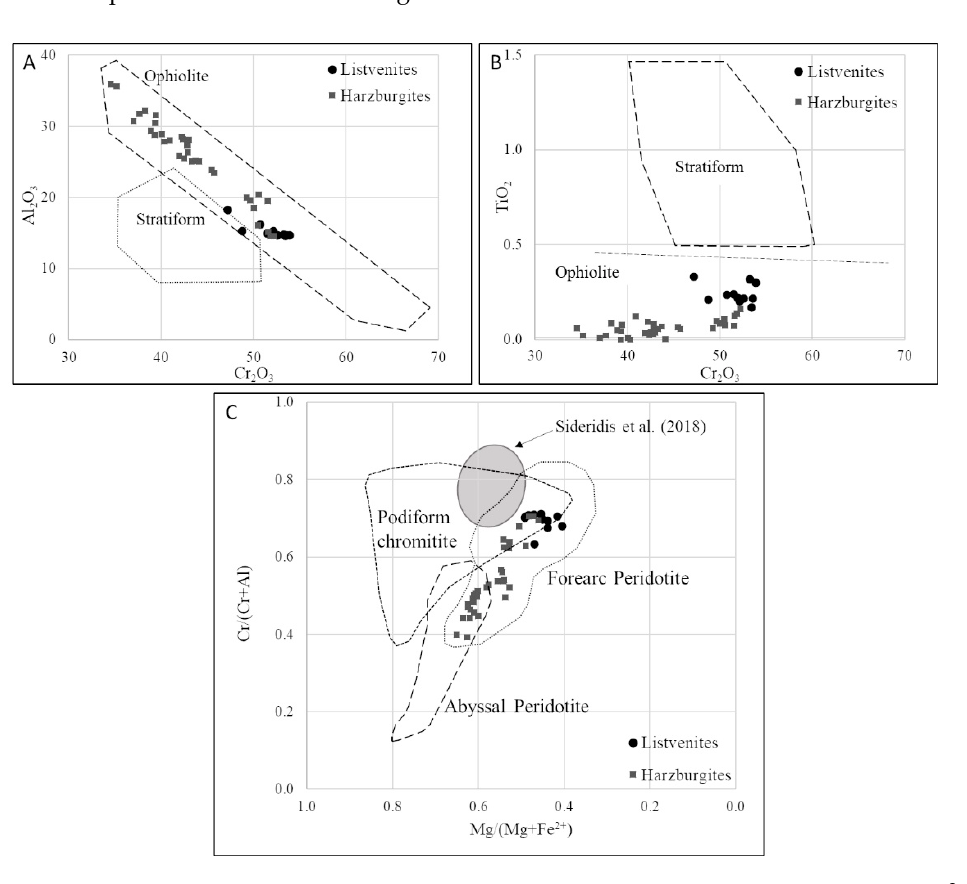
Figure 9. Cr 2 O 3 vs. Al 2 O 3 ( A ) and TiO 2 ( B ) of the Rachoni peridotite chromites; ( C ) Mg/(Mg+Fe 2+ ) vs. Cr/(Cr+Al) of Rachoni peridotites chromite compared to chromitite chromites from the same area. Compositional fields for abyssal peridotites [25–27], forearc peridotites [26] and podiform chromitites [23,24,28] are shown for comparison.